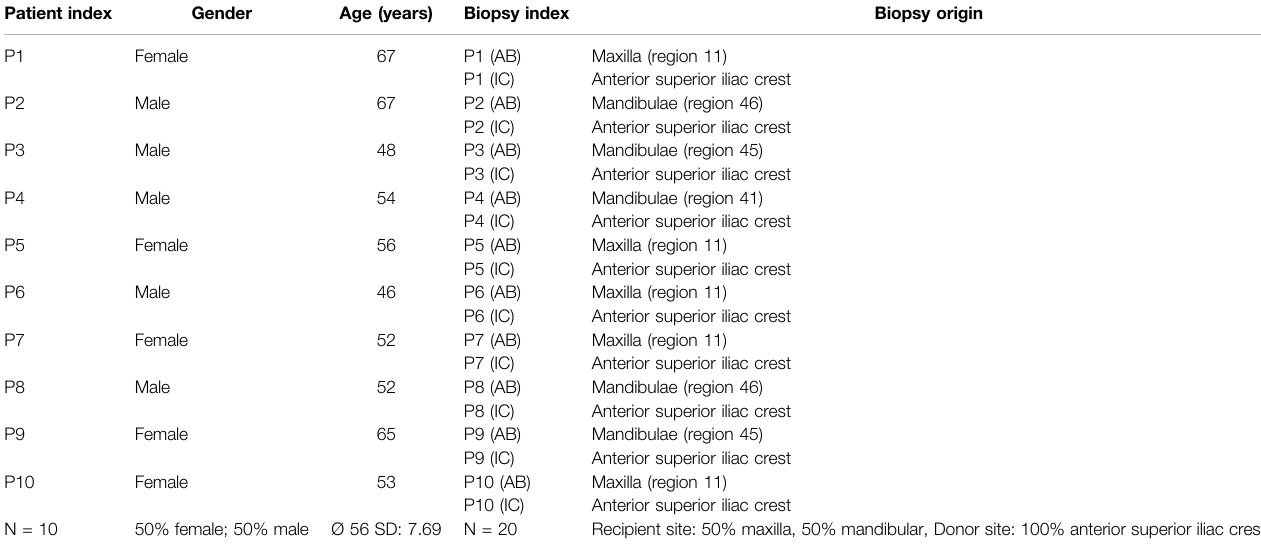
TABLE 1 | Patient and sample